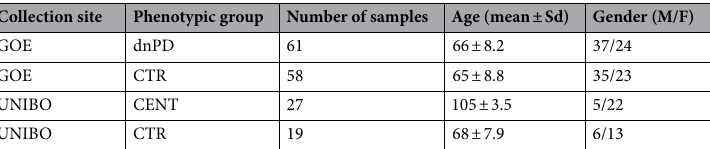
Table 1. Samples of the discovery cohort processed by Next Generation Sequencing. The healthy controls cohort (CTR) consists of 77 samples, 58 of which belonging to the University of Goettingen (GOE) and the remaining 19 to the University of Bologna (UNIBO). The dnPD samples all belong to the GOE site. The 27 centenarians’ samples (CENT) are from